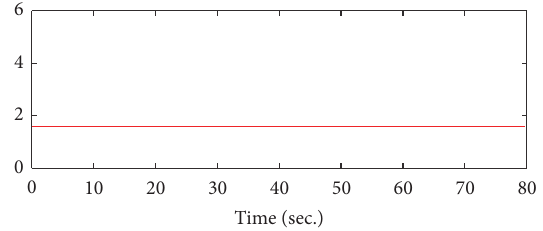
Figure 13: Algebraic connectivity value during simulation of multi- agent velocity convergence in multiple size multiple